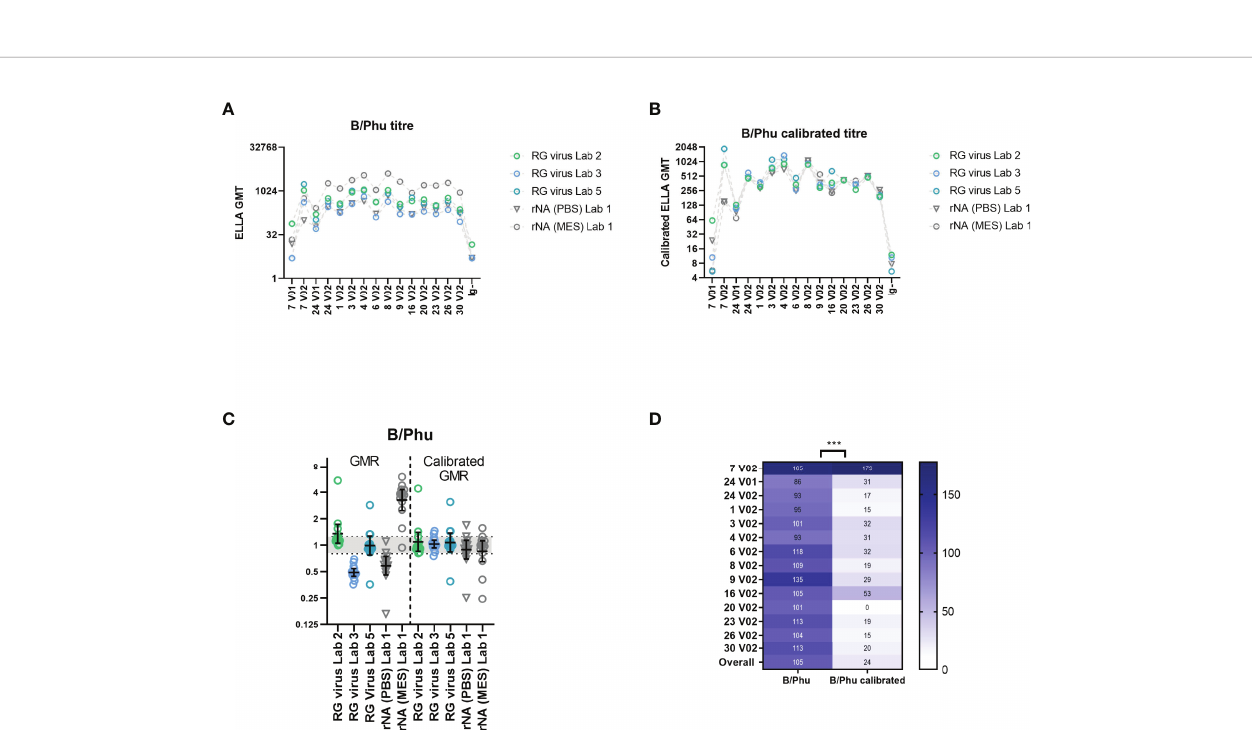
FIGURE 8 | Comparison of B/Phuket/3073/2013 rNA and mismatched HA/NA reverse genetics (RG) viruses in ELLA-NI and calibration using a mid-titre serum sample. (A) ELLA-NI titres for B/Phuket/3073/2013 (B/Phu) RG virus tested in three labs (Labs 2/3/5) and rNA from B/Phuket/3073/2013 tested in one lab with either a DPBS buffer [rNA (PBS)] or an MES buffer [rNA (MES)]. (B) ELLA titres as in [A] after calibration with mid-titre serum sample 20 V2. (C) Geometric mean ratios (GMR) of B/Phuket/3073/2013 RG virus and rNA ELLA-NI titres before and after calibration. The geometric mean and 95% CI are shown in black (D) %GCV per sample across the 5 labs/methods before and after calibration. *** indicates signi fi cance using the Wilcoxon matched pairs test [P=0.0002].